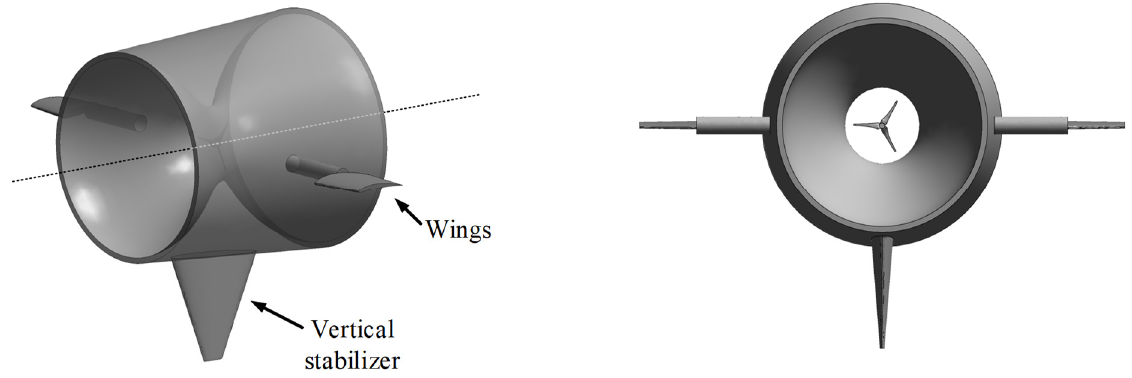
Figure 25. Optimized circular nozzle-diffuser duct designed by harmony search method.